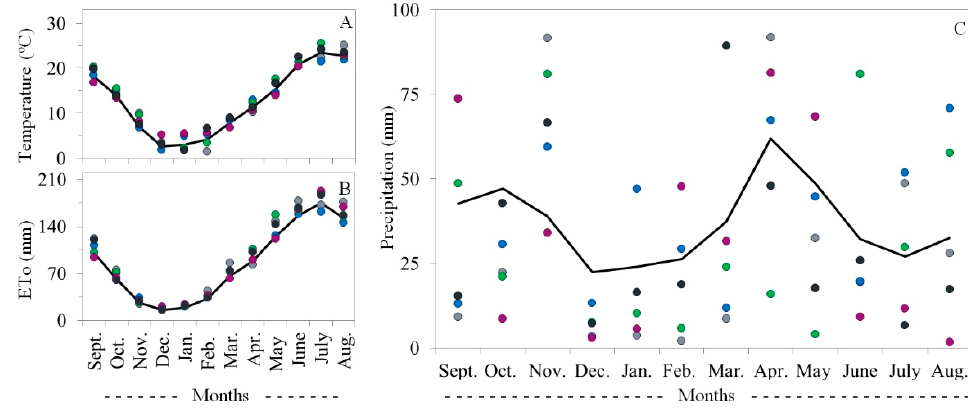
Figure 4. Monthly average temperature ( A ), total monthly evapotranspiration (Penman-Monteith equation) ( B ) and total monthly precipitation ( C ) for the experimental period (2002–2017). Specific values for the evaluated years are also shown.